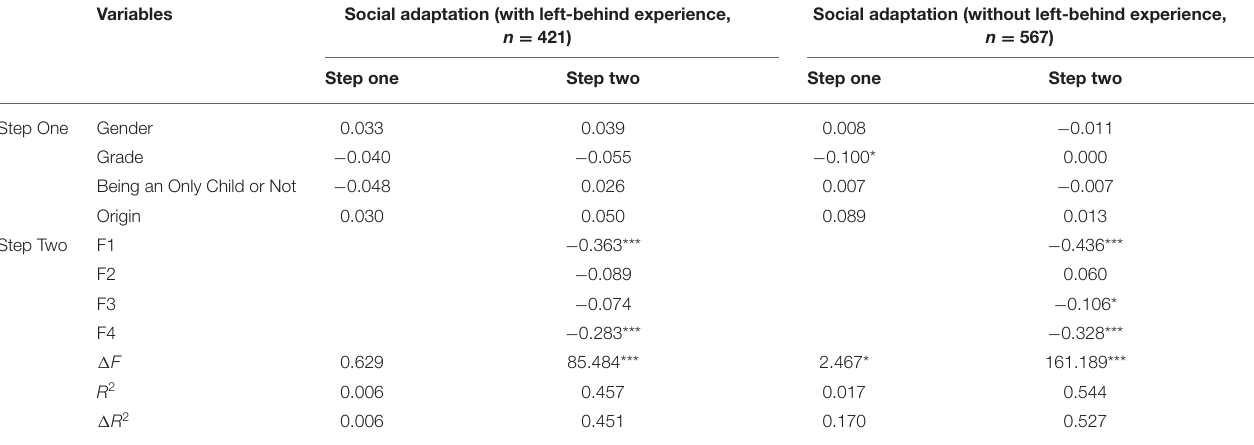
TABLE 5 | Regression analysis of life meaning on social adaptation. Variables Social adaptation (with left-behind experience,